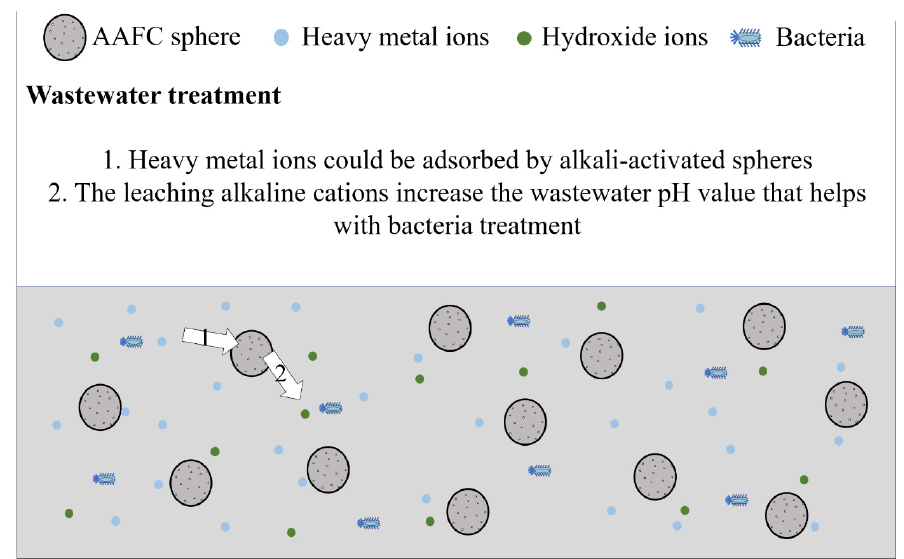
Figure 5. The prospects of using the AAFC sphere for wastewater treatment.